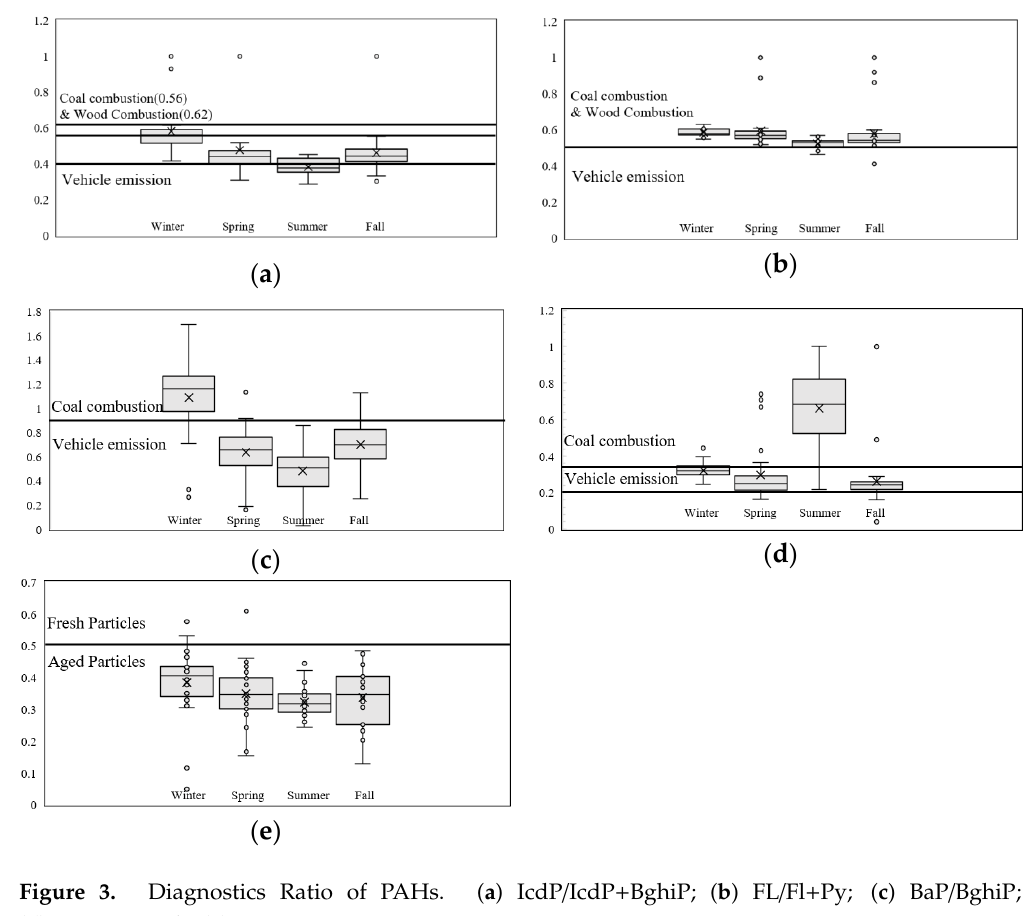
Figure 3. Diagnostics Ratio of PAHs. ( a ) IcdP/IcdP+BghiP; ( b ) FL/Fl+Py; ( c ) BaP/BghiP; ( d ) BaA/BaA+Chr ( e )BaP/BaP+BeP.